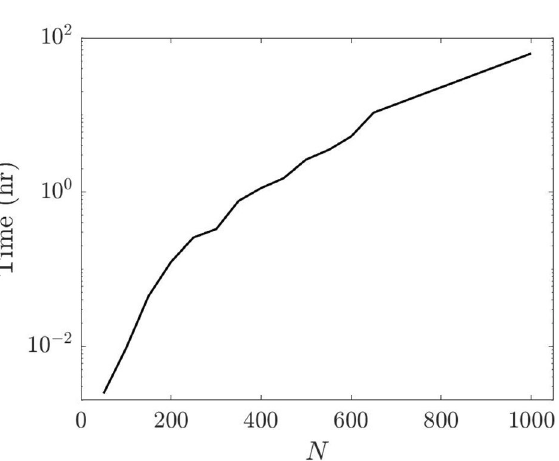
Figure 6. Correction cost (blue curves) with statistical significance analysis (red bars) for real world networks. ( A ) US Air network. ( B ) Freeman’s researcher network. ( C ) Stock market network. ( D ) Brain network.